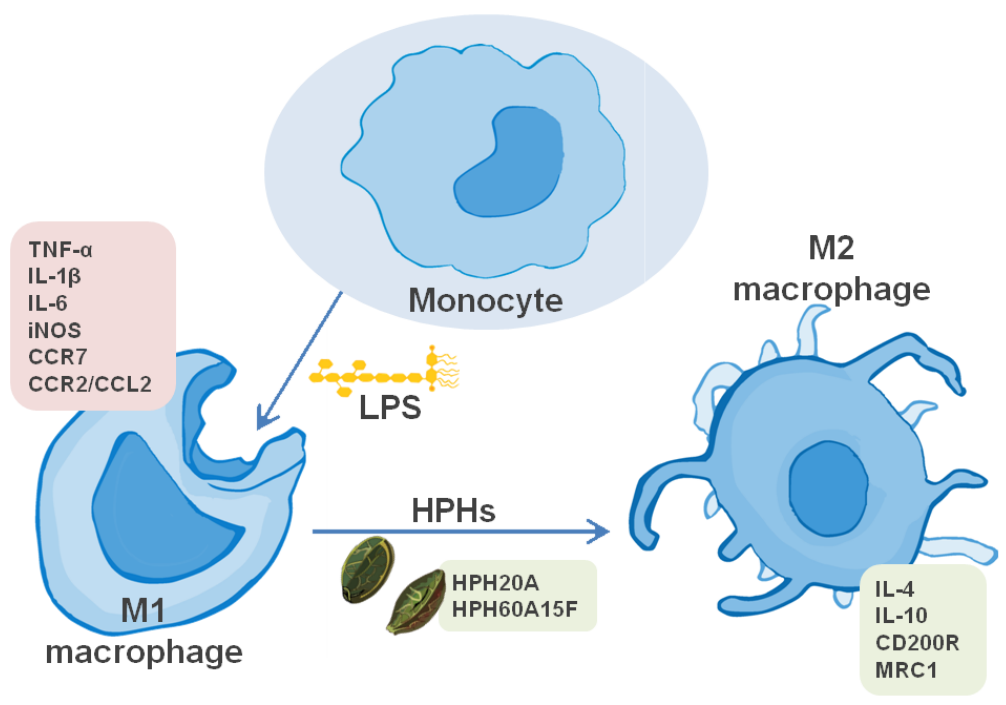
Figure 5. Schematic representation of the actions of HPHs in LPS-stimulated primary human monocytes. The scheme summarizes the hypothesis by which HPHs would acutely modulate the polarization of human monocyte into M2 macrophage. This model does not exclude the participation of additional mechanisms of action for HPHs to achieve their effects on the macrophage polarization.